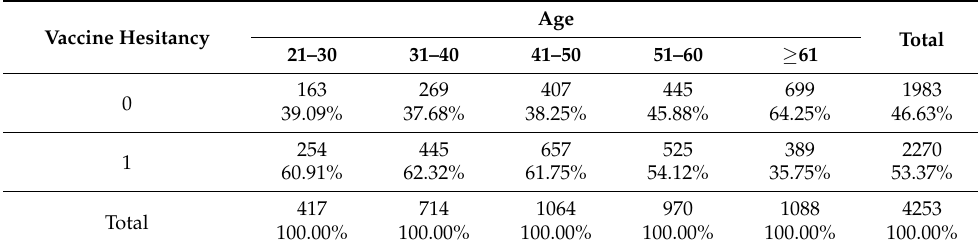
Table 4. Distribution of vaccine hesitancy by age